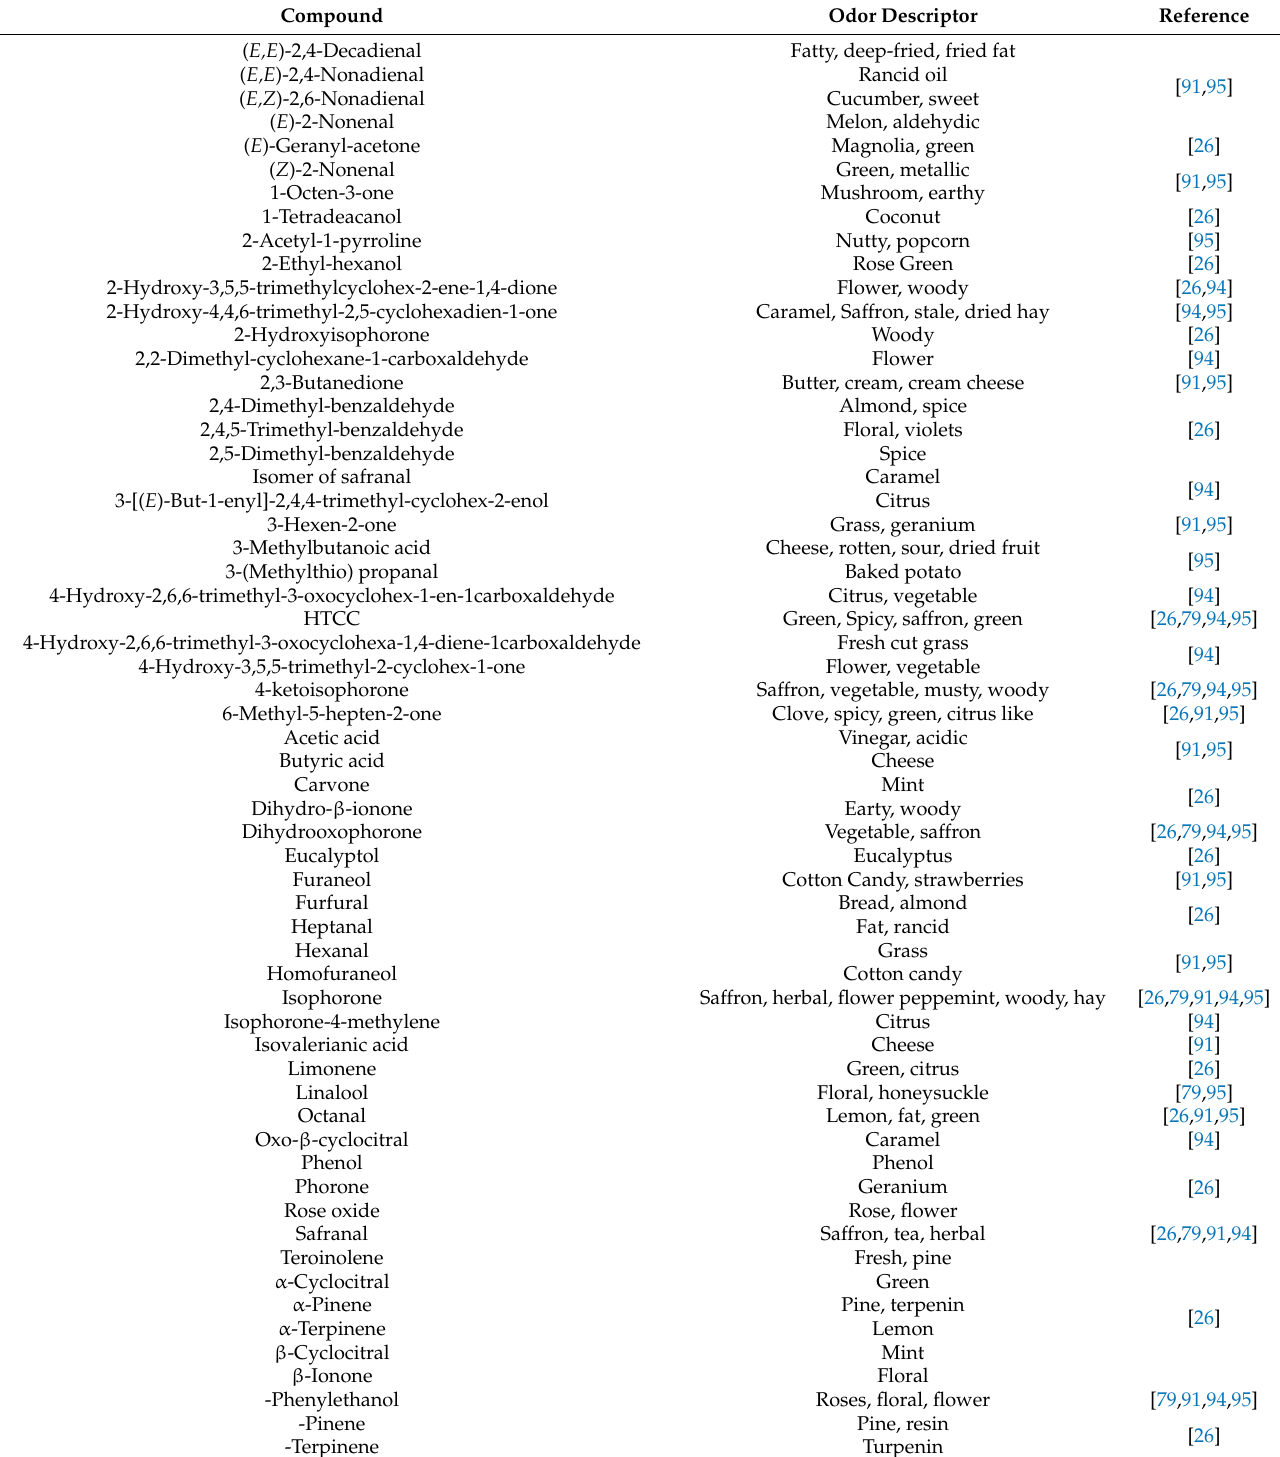
Table 2. Saffron volatile chemical compounds with their respective odor